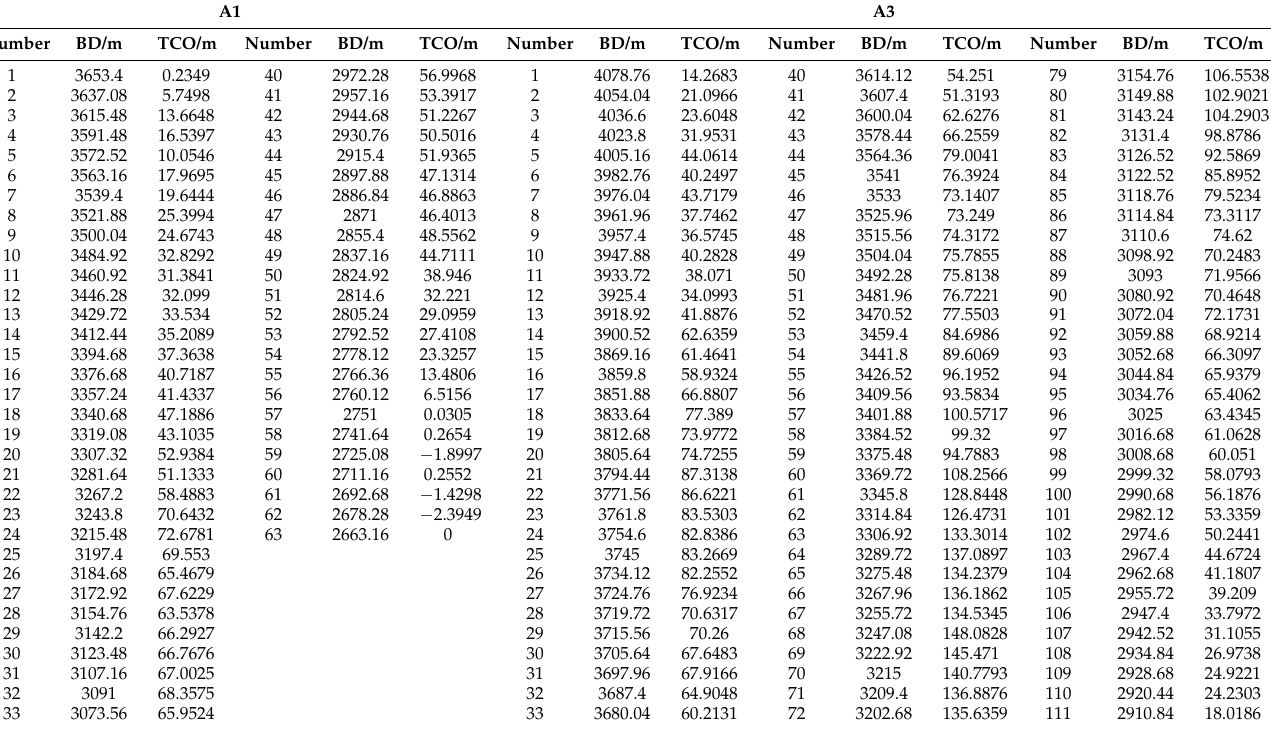
Table 1. SQD 3 high-frequency cycles thickness cumulative offset of well A1 and